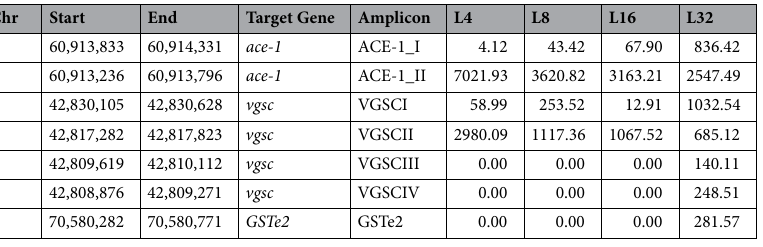
Table 1. Coverage for An. stephensi eDNA-L4, -L8, -L16, and -L32 insecticide resistance amplicon targets. Chromosome number (chr), start and end of the target amplicon, the target gene, amplicon name and coverage are